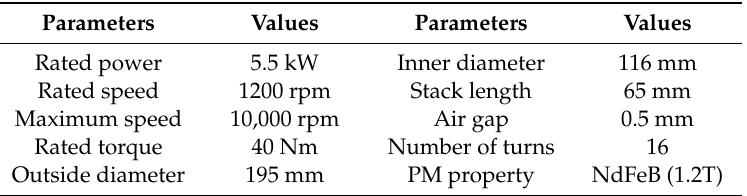
Table 1. Main design specifications of the